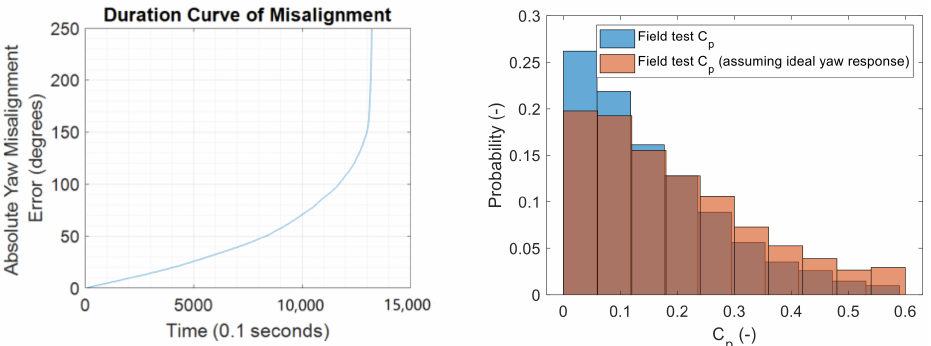
Figure 11. ( left graph) Duration curve of the absolute yaw misalignment error (degrees), ( right graph) histogram of probability of occurrence for C p values assuming ideal yaw response and comparison with actual measured from the 22 min dataset obtained in the field.